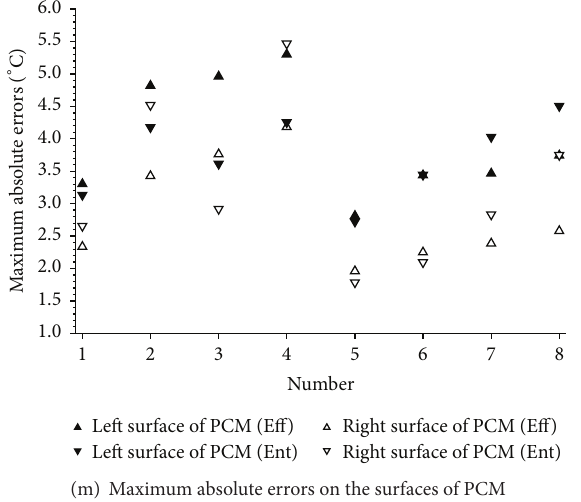
Figure 6: Experimental data of Block 3 wall and calculation